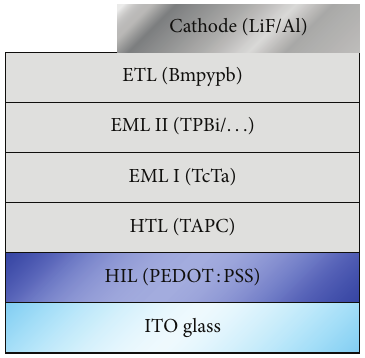
Figure 3: The structure of OLED device manufactured.